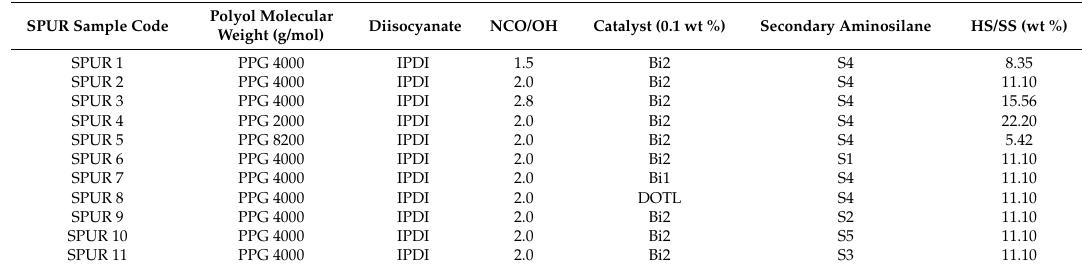
Table 2. The sample codes and compositions of the synthesized SPUR prepolymers.